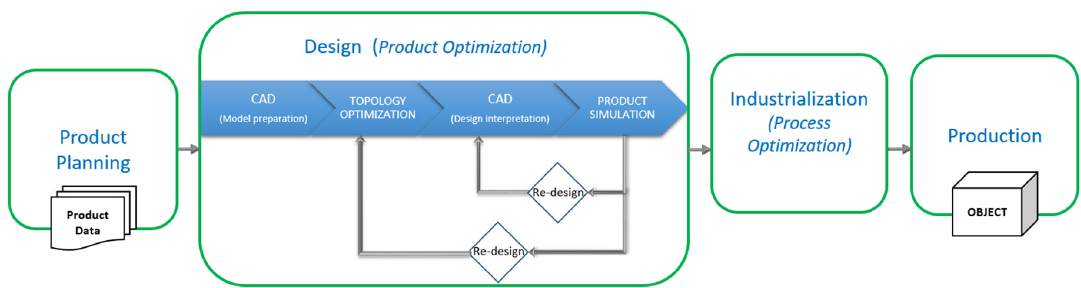
Figure 1. General design for additive manufacturing workflow.